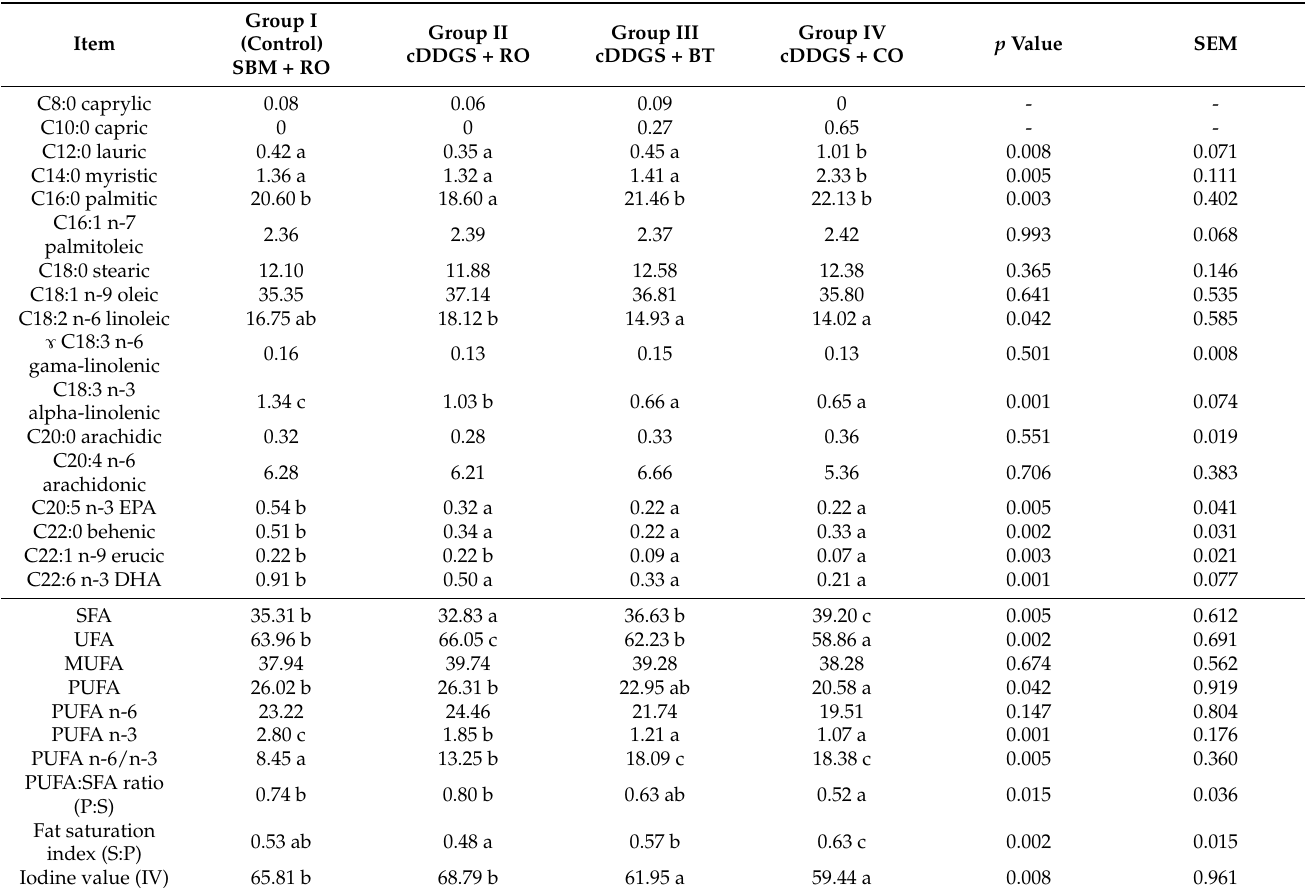
Table 2. Fatty acid profile in longissimus muscle